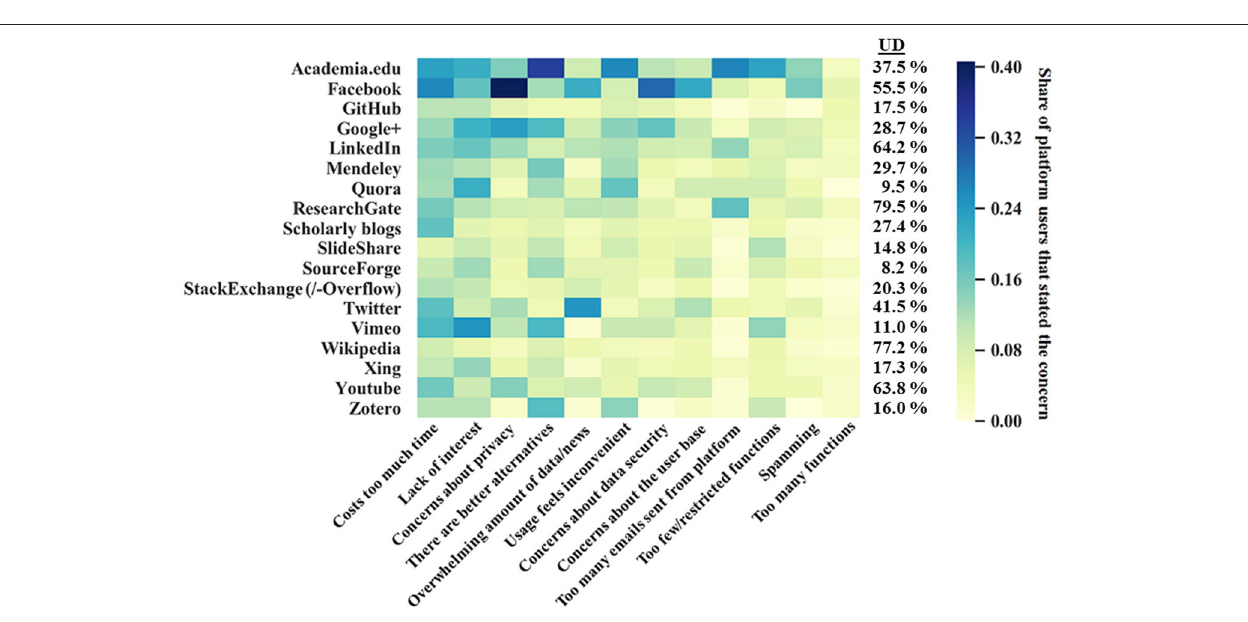
FIGURE 4 | Social scientists’ concerns regarding social media usage for work purposes